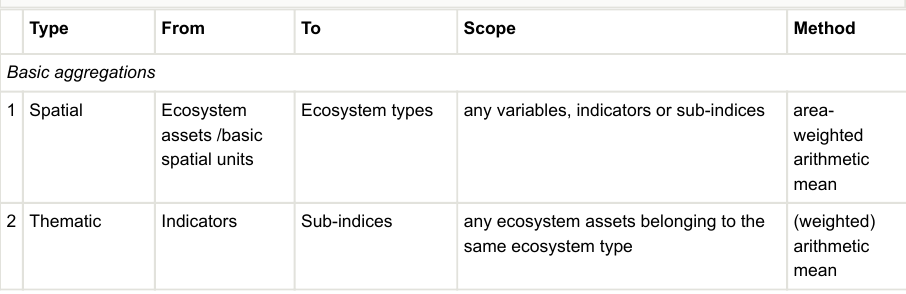
Types of aggregation for ecosystem condition